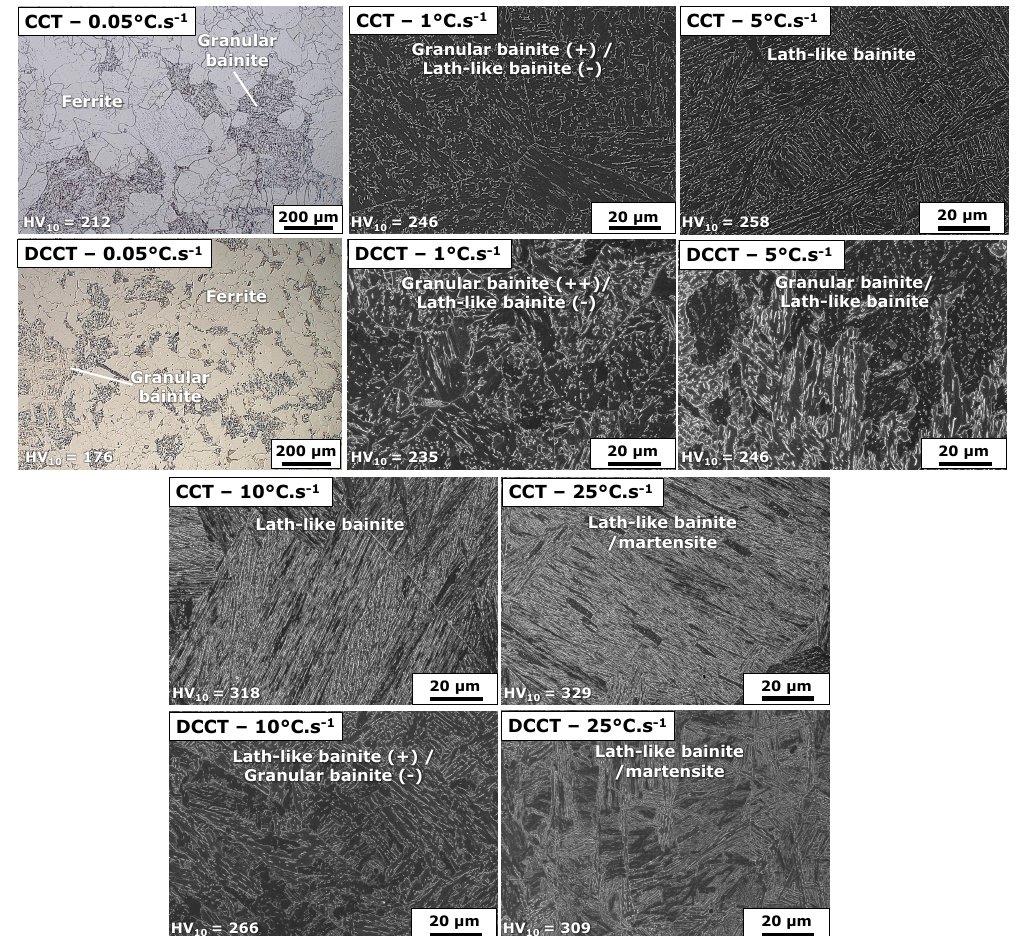
Figure 5. Microstructures resulting from continuous cooling experiments starting from undeformed austenite (CCT) and deformed austenite (DCCT). The (+) and (-) are indications of the major and minor phase constituent,